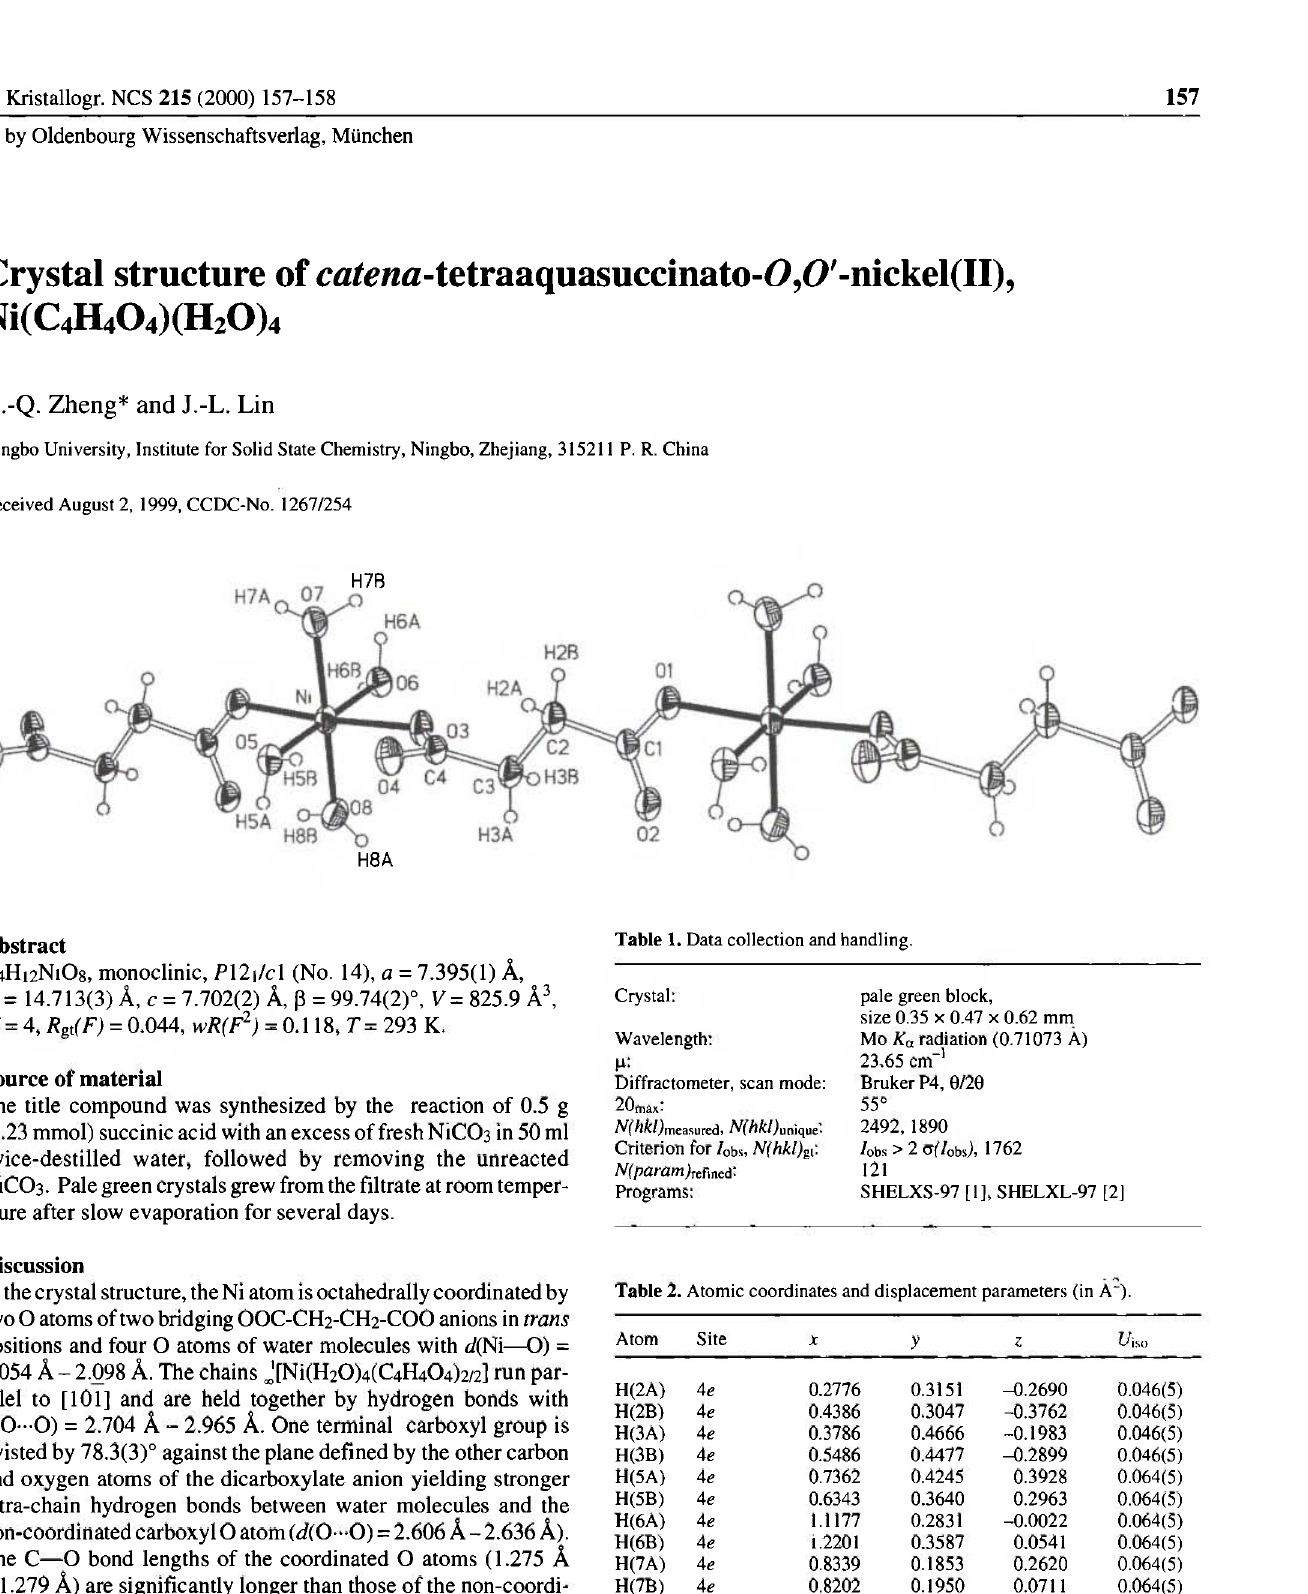
Table 1. Data collection and handling.